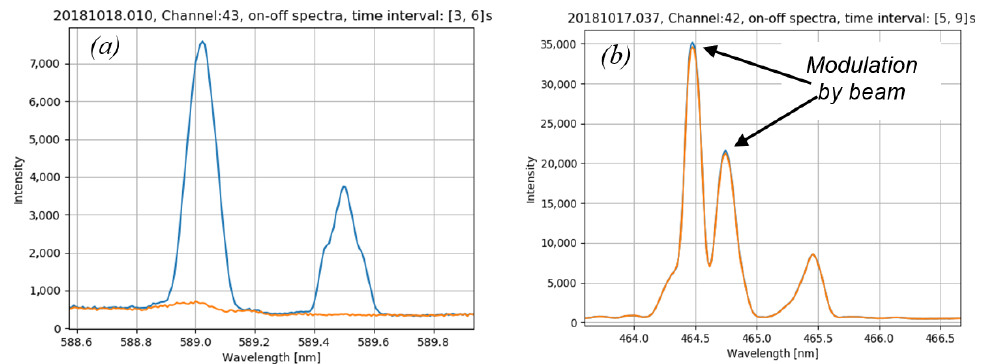
Figure 2. The sodium beam spectrum ( a ) and a potential CX line spectrum ( b ) when the alkali beam is on (blue) and off (orange).